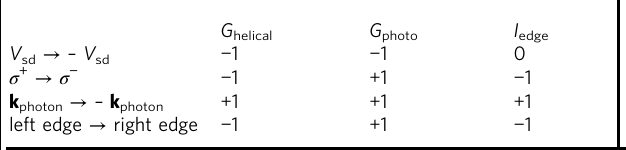
Table 1 Symmetry chart of G helical and G photon compared to edge photocurrent phenomena